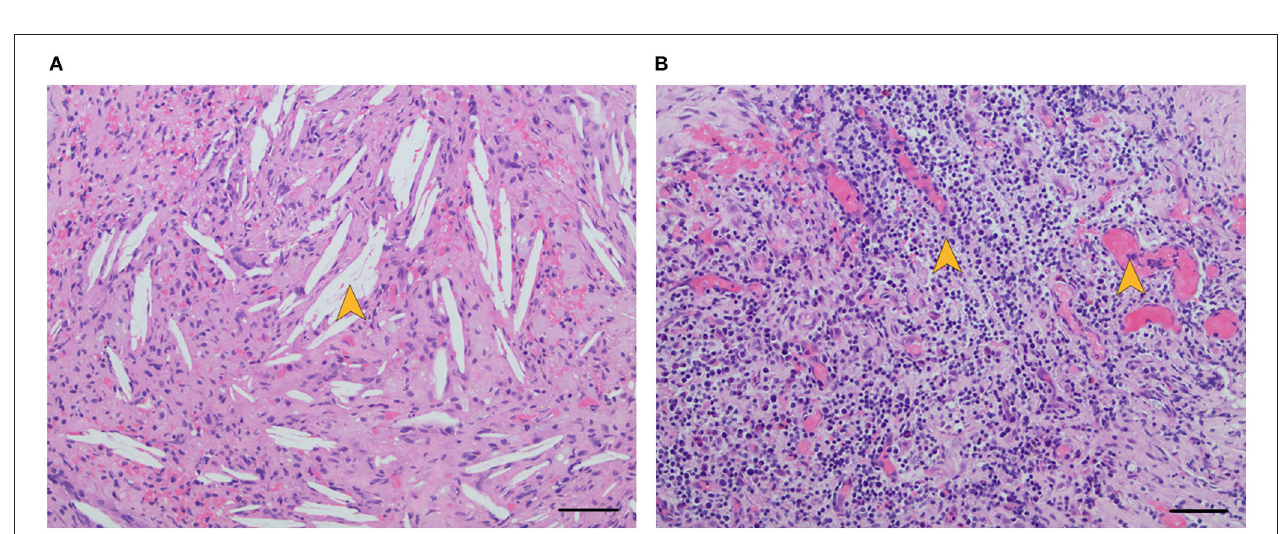
FIGURE 2 | (A,B) Computed tomographic images of the temporal bone showed fistulae (yellow arrows) in both the basal turn of the cochlea and the horizontal semicircular canal. (C) Fistulae in both the basal turn of the cochlea and the horizontal semicircular canal were evident during the operation. Co, cochlea; ET, epitympanum; F, fistula; FN (m), mastoid segment of facial nerve; LSC, lateral semicircular canal; MFP, middle fossa plate.